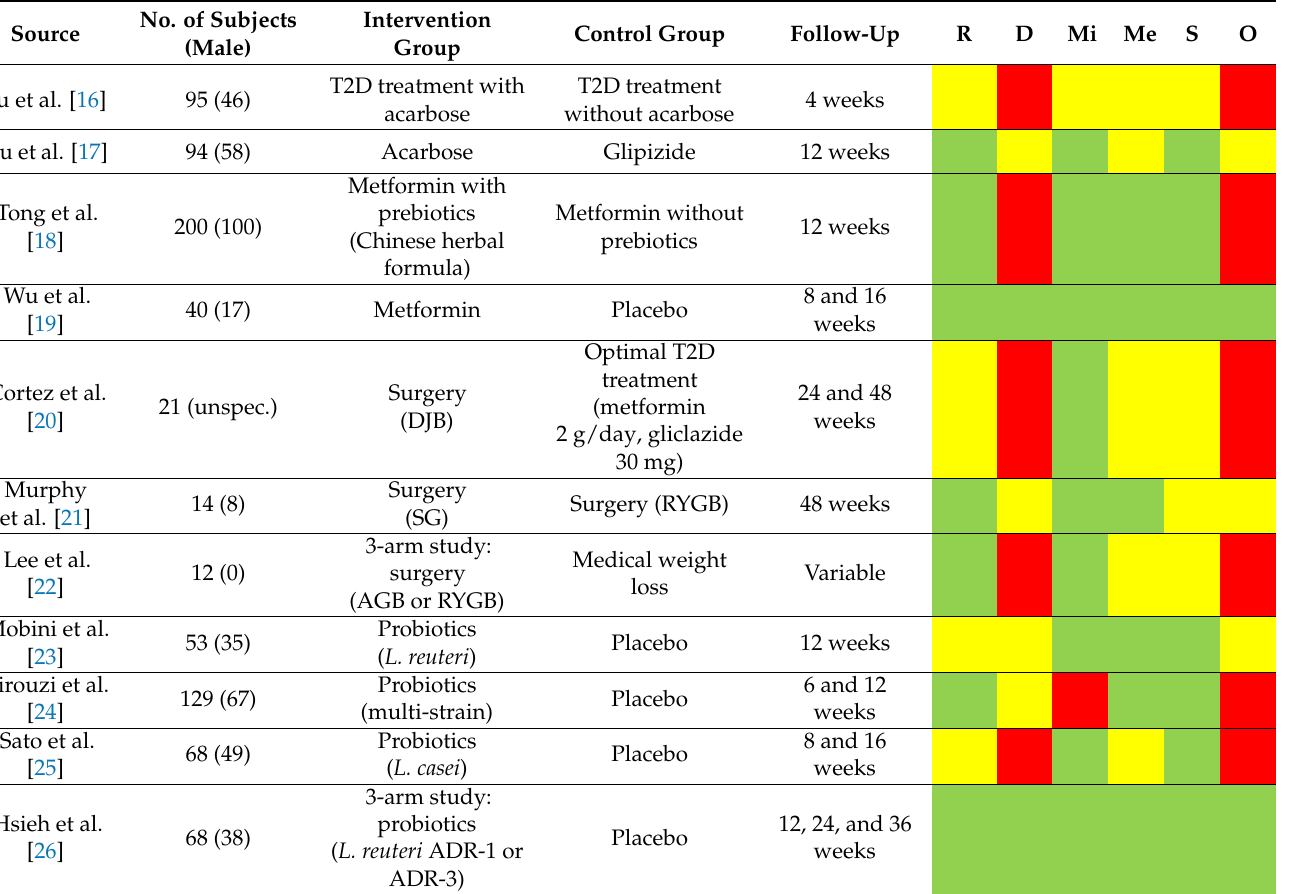
Figure 1. PRISMA flow diagram detailing the inclusion process. Table 1. General view of included trials and risk-of-bias evaluation.